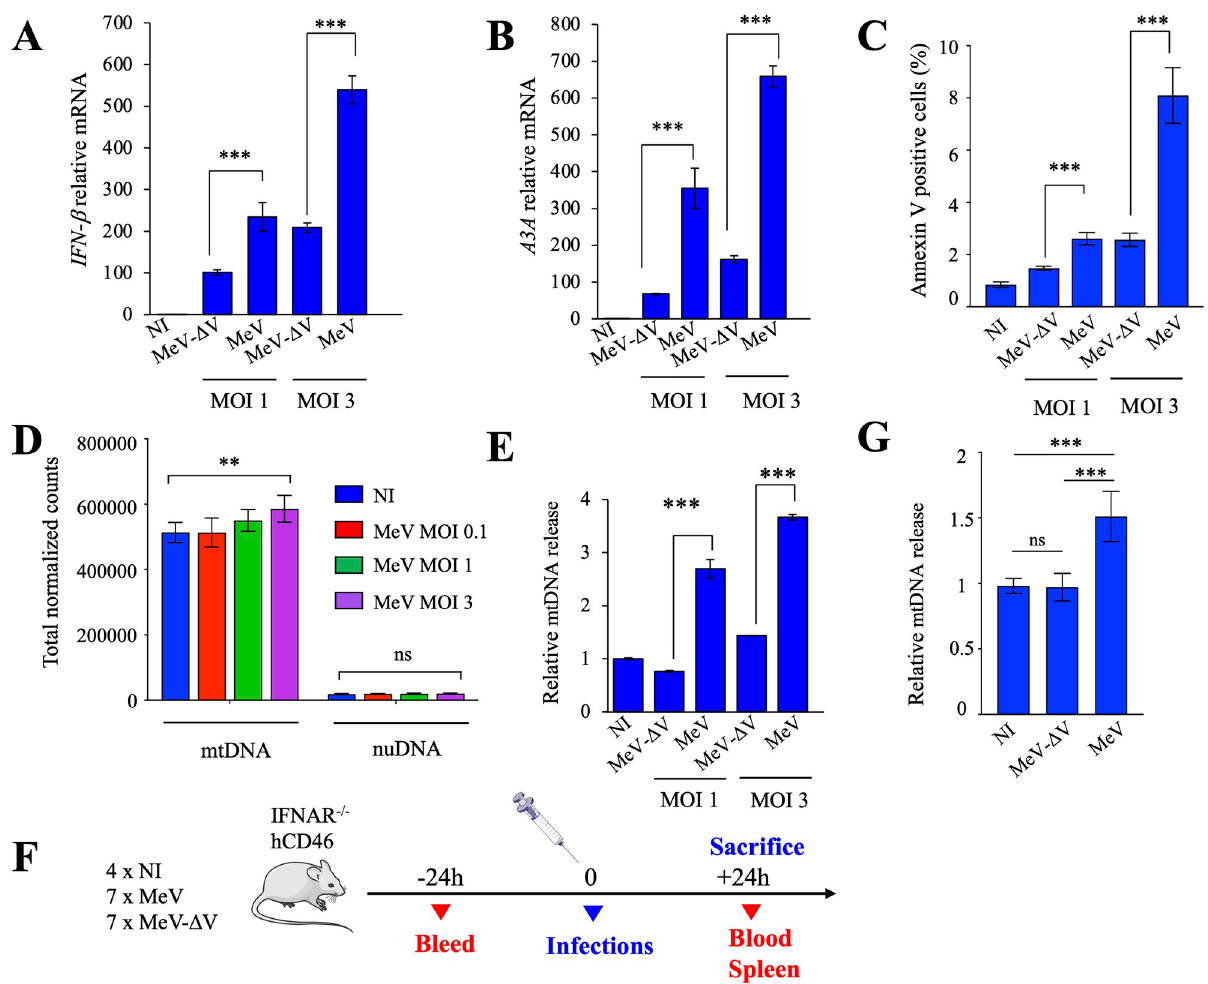
Fig 2. Cytosolic mitochondrial DNA release upon MeV and MeV- Δ V infection in culture and in mice. A-B) Relative expression of IFN- β and APOBEC3A following MeV- Δ V or MeV infections at MOI 1 and 3 at 24 hpi. Gene expression was normalized using the expression level of the housekeeping gene RPL13A . C) Flow cytometry analysis of the Annexin V positive cells at 24 hpi by MeV- Δ V or MeV at MOI 1 and 3. A-C), Mean values and s.e.m. were calculated for three independent infections (n = 3) (unpaired two-side Student’s t-test, ��� , p < 0.005). D) Whole genome amplification of cytosolic DNA upon infection of MeV at MOI 0.1, 1 and 3 and blast to the human genome. E) THP-1 cells were fractioned at 24 hpi and mtDNA quantification was performed using the MT-COI gene in the cytosolic fraction and normalized to the quantification of the nuclear gene β 2M of the total fraction. Mean values and s.e.m. were calculated for three independent infections in duplicate (n = 6) (unpaired two-side Student’s t- test, ��� , p < 0.005 and ns: not statistically significant). F) IFNAR − / − hCD46 mice were infected by intraperitoneal injection with 1 × 10 5 TCID 50 of MeV (n = 7), MeV- Δ V (n = 7) or 100 μ l PBS, (n = 4). At -24h and 24h after infection, blood and spleen were collected. G) CD11b + cells from infected mice were fractioned and mtDNA quantification was performed using the MT-COI gene in the cytosolic fraction and normalized to the quantification of the nuclear gene β 2M of the total fraction. Unpaired two-side Student’s t-test, ��� , p < 0.005 and ns: not statistically